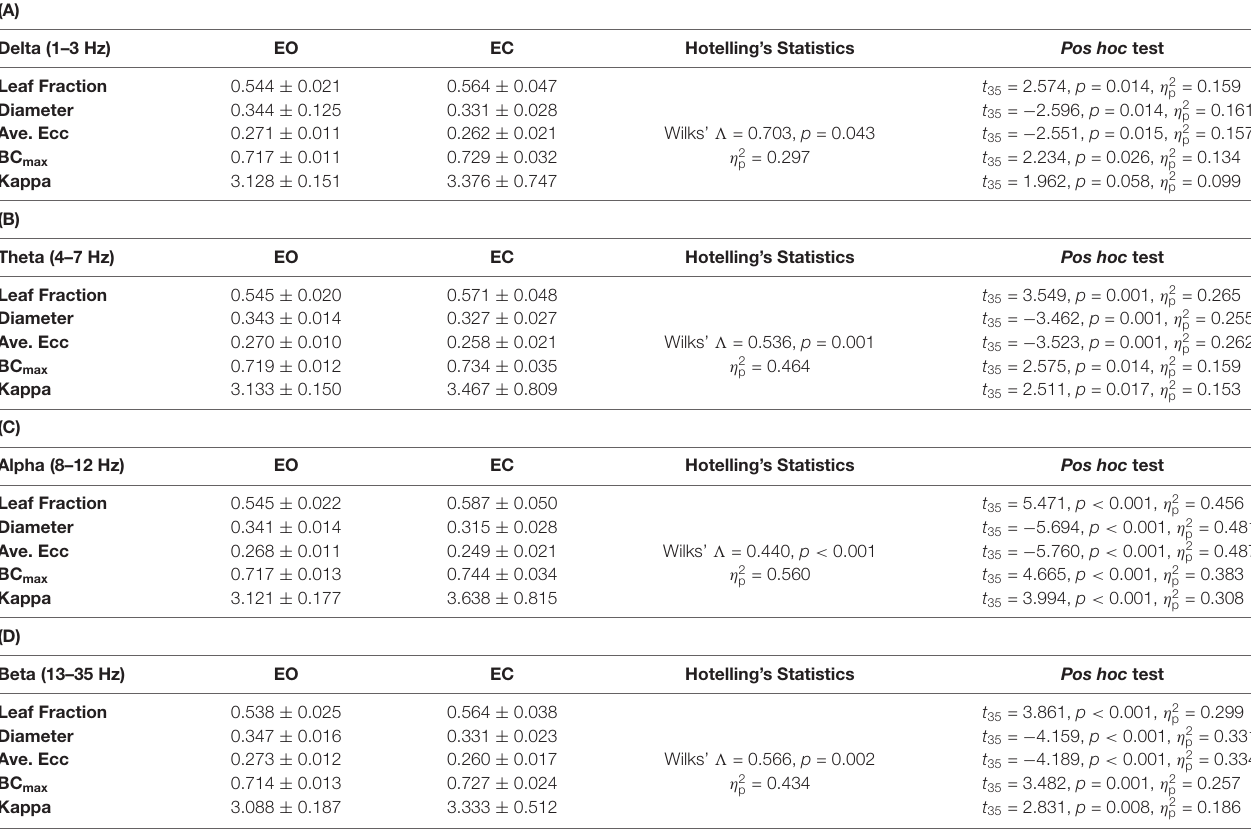
TABLE 4 | The contrast population means of network integration graph measures between the eyes-open (EO) and eyes-closed (EC)